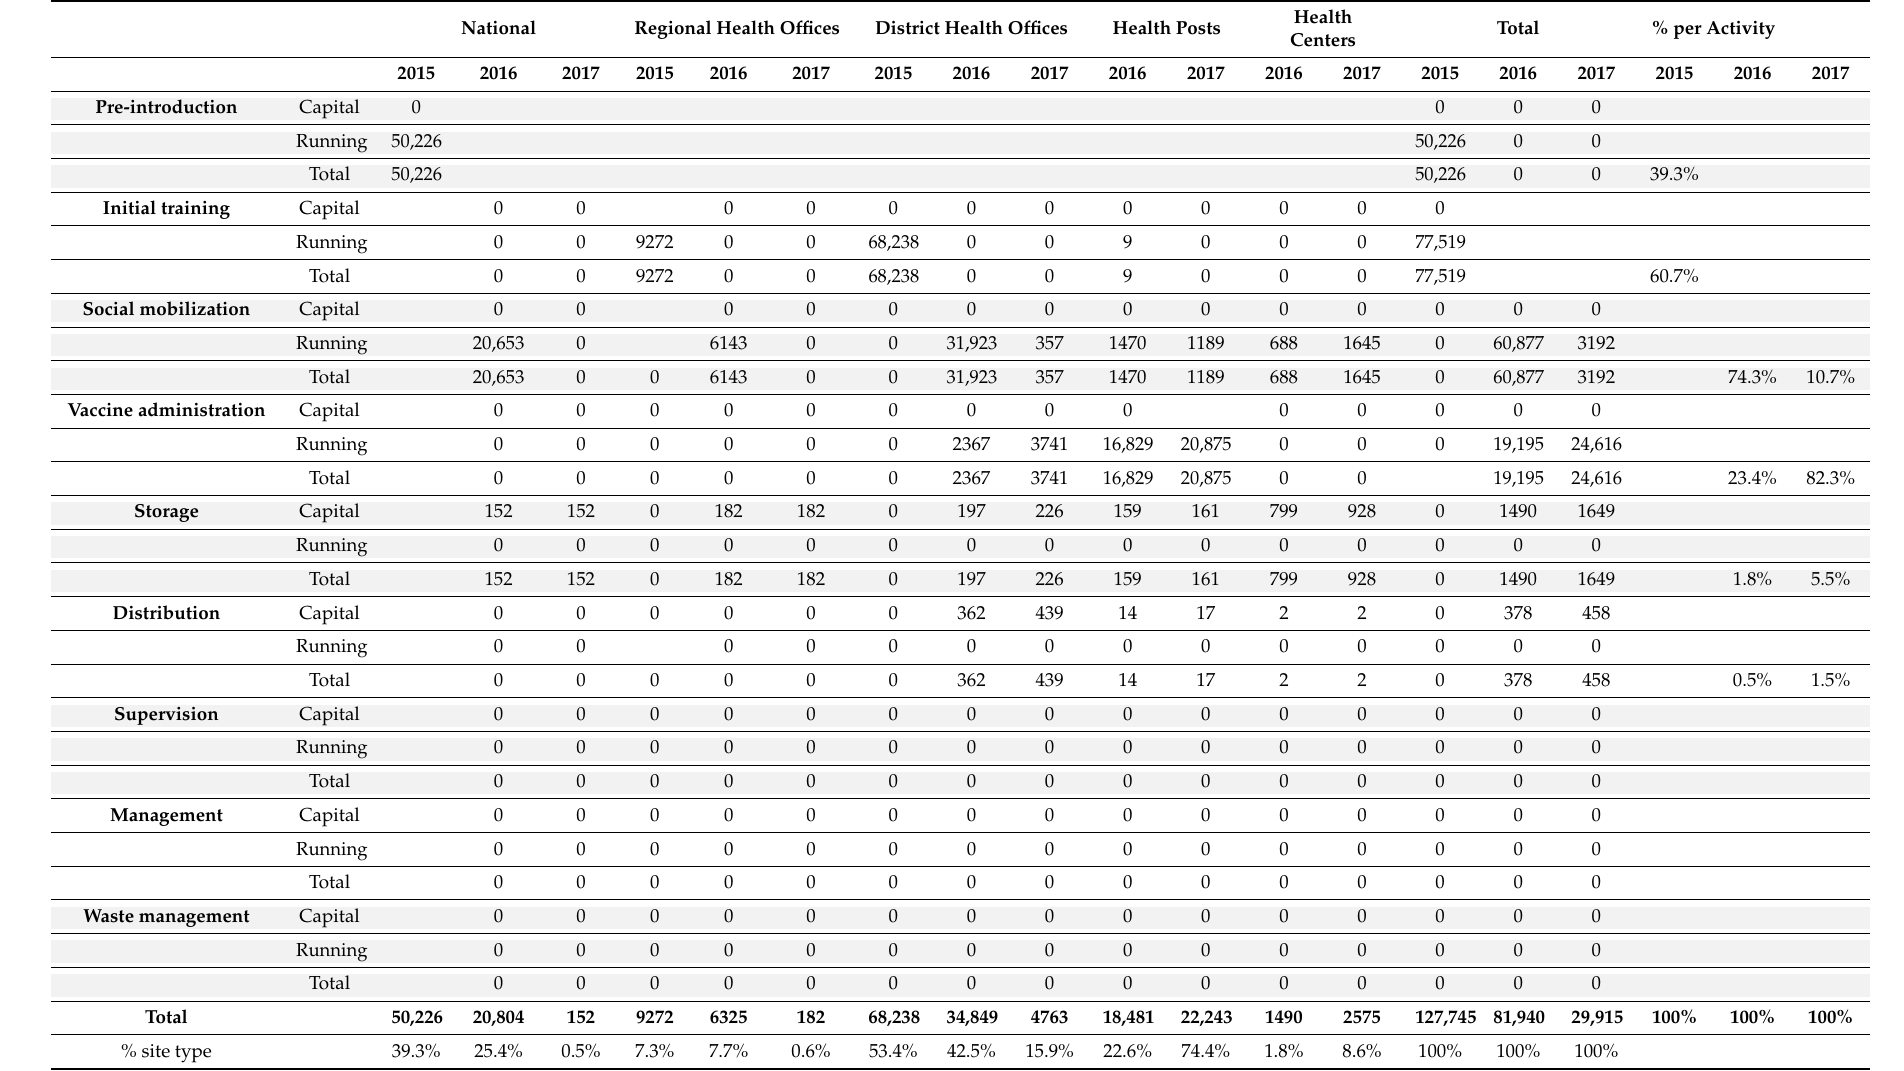
Table 4. Aggregated financial costs (in USD 2016) per activity and per study